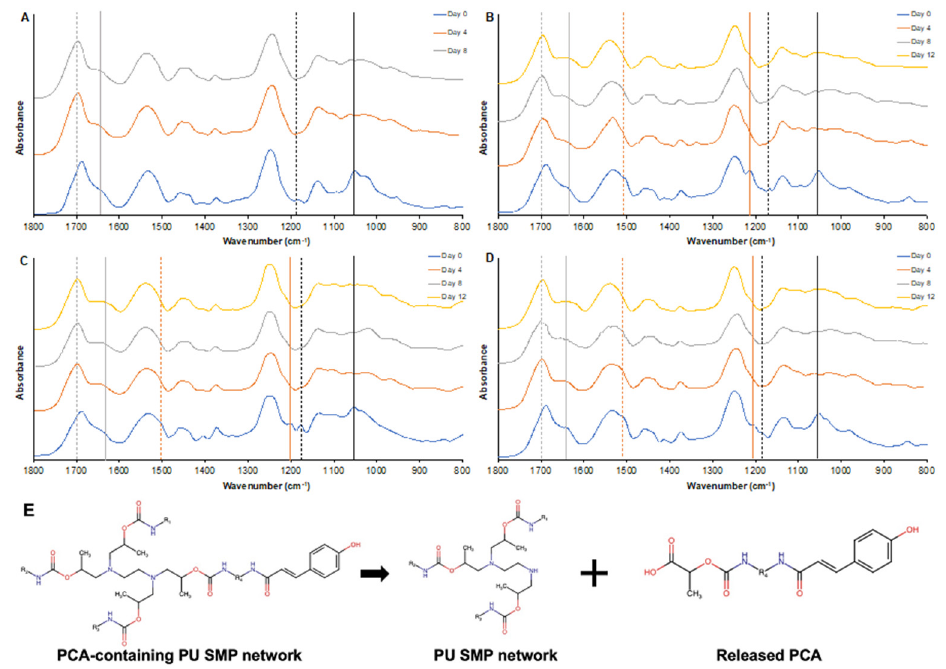
Figure 4. Spectroscopic analysis of ( A ) control, ( B ) PCA, ( C ) VA, and ( D ) FA SMP foams in 20% H 2 O 2 over 12 days via ATR-FTIR. The grey dashed line shows the urethane C=O peak shift from 1680 cm − 1 to 1690 cm − 1 and the grey solid line shows the urea C=O peak at 1636 cm − 1 . The black dashed line at 1165 cm − 1 and the black solid line at 1050 cm − 1 shows the tertiary amine peak. The orange dashed line shows the C=C of the phenolic ring at 1500 cm − 1 and the orange solid line shows the C–CH of the phenolic ring at 1180 cm − 1 . ( E ) Schematic of the scission of the tertiary amines of HPED leading the release of incorporated PCA from the PCA foam network in the accelerated degraded process. VA and FA share a similar release process from PU foams.